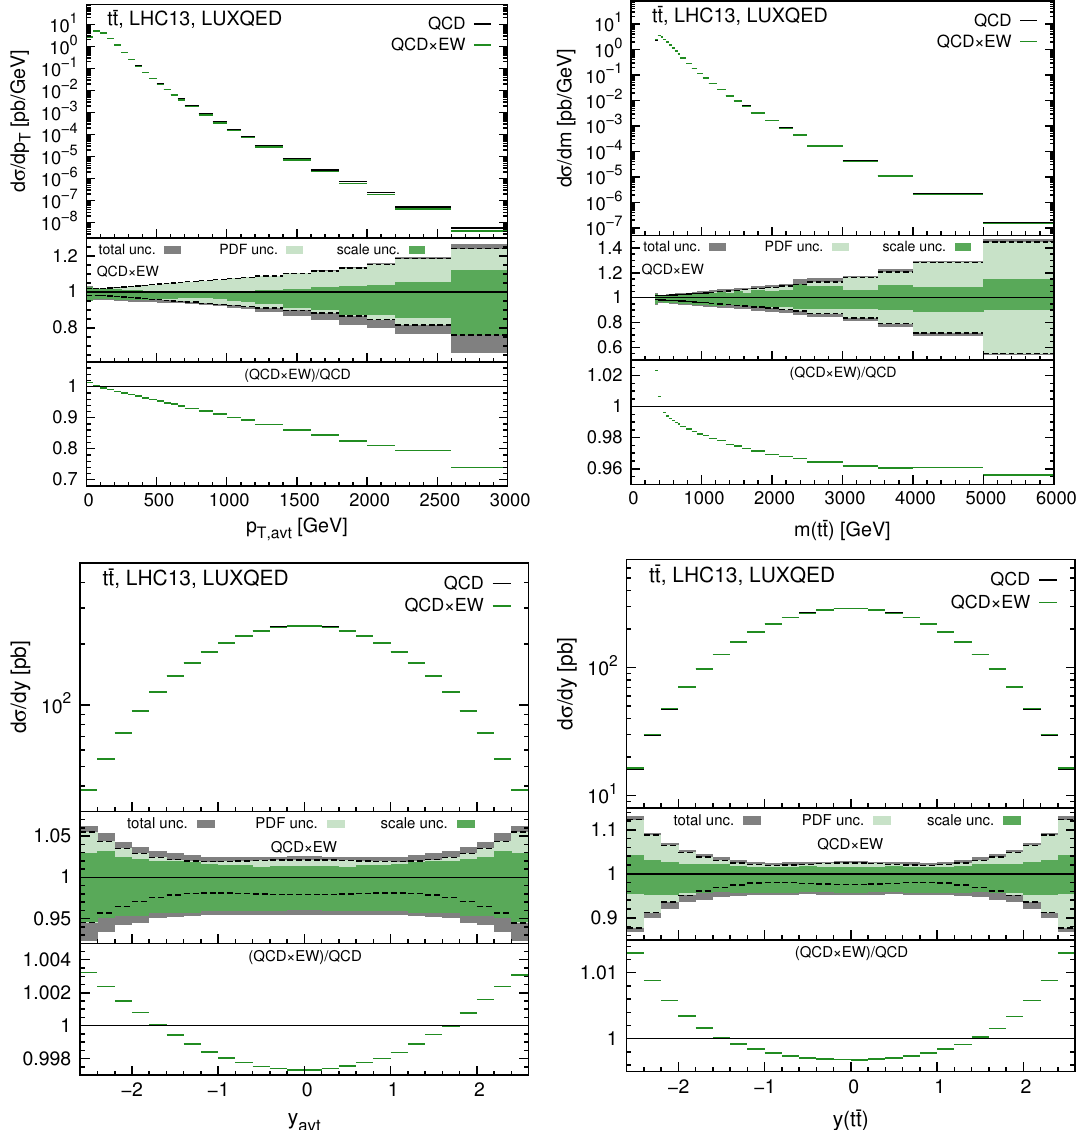
Figure 1 . Our best predictions for the four LHC 13 TeV t (cid:22) t di(cid:11)erential distributions considered in this work. The predictions are based on the multiplicative approach. Shown are the scale, PDF and combined (in quadrature) theory uncertainties for each QCD (cid:2) EW distribution. The boundaries of the PDF variation band are marked with black dashed lines. Also shown is the ratio of central scales for the combined QCD and EW prediction with respect to the NNLO QCD